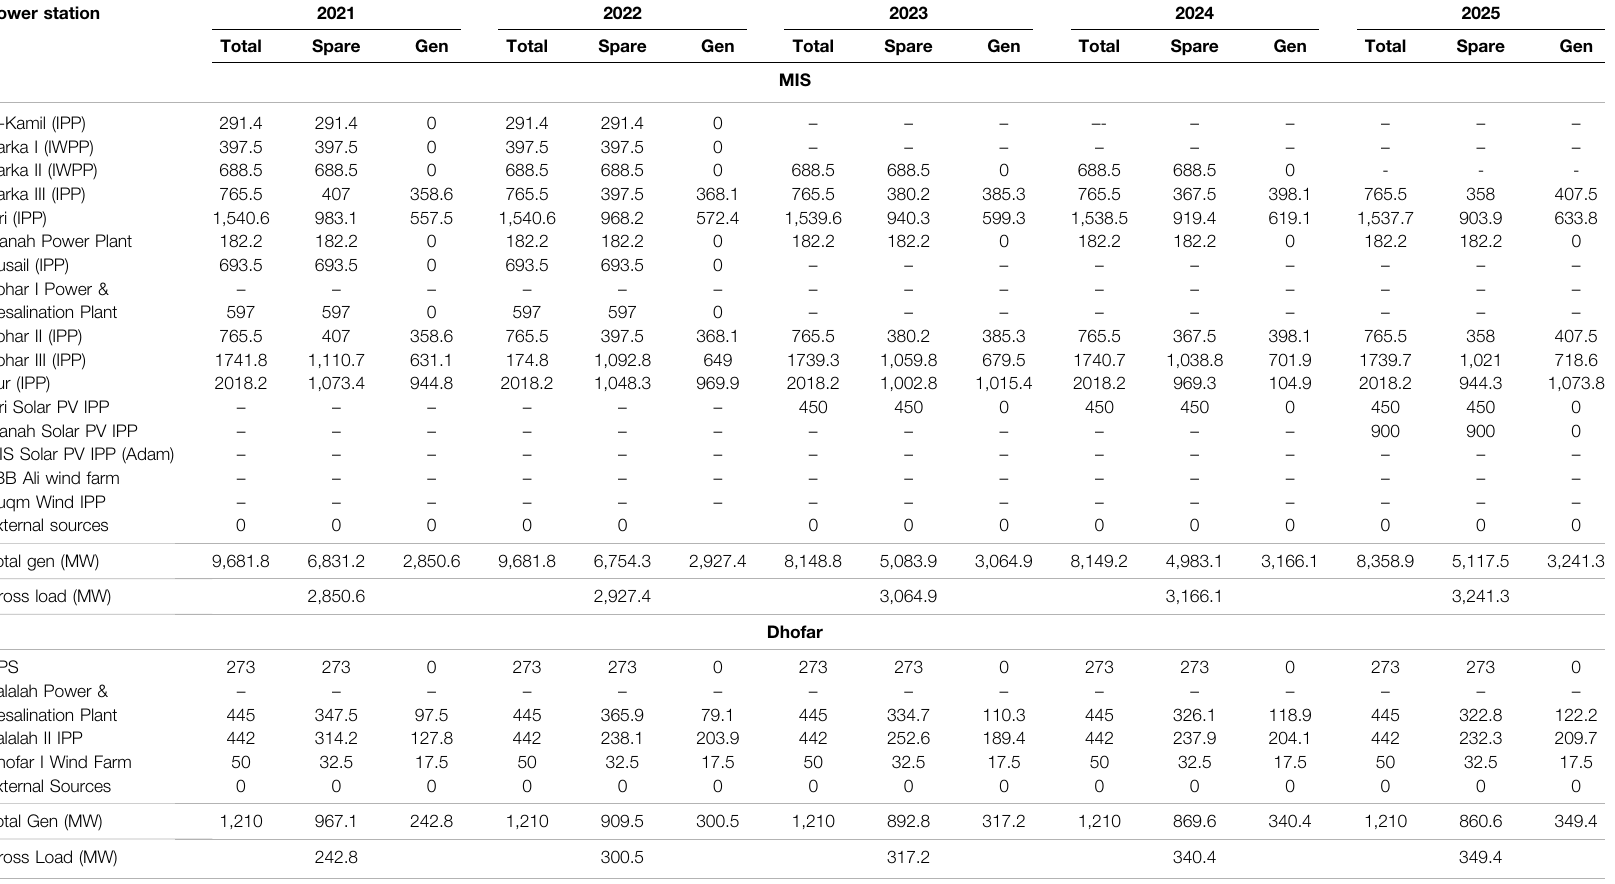
TABLE 4 | Summary of connected generation used in load fl ow studies of minimum demand. Power station